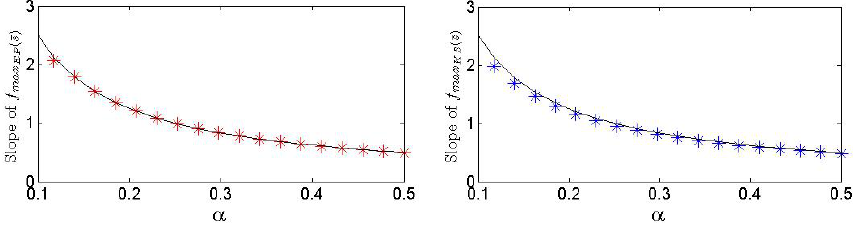
s . Note that the approximation f max 4 α